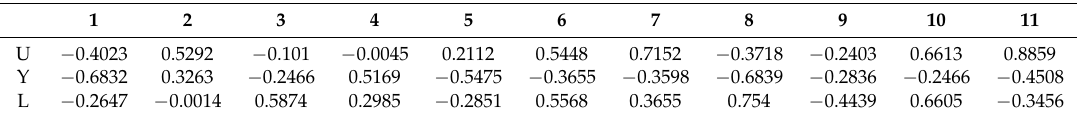
Table 4. The coefficient of the outer layer parameters and the second hidden parameters’ quantitative formulae.